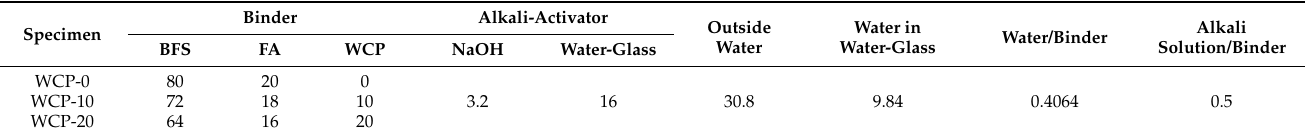
Table 3. Mixtures of paste